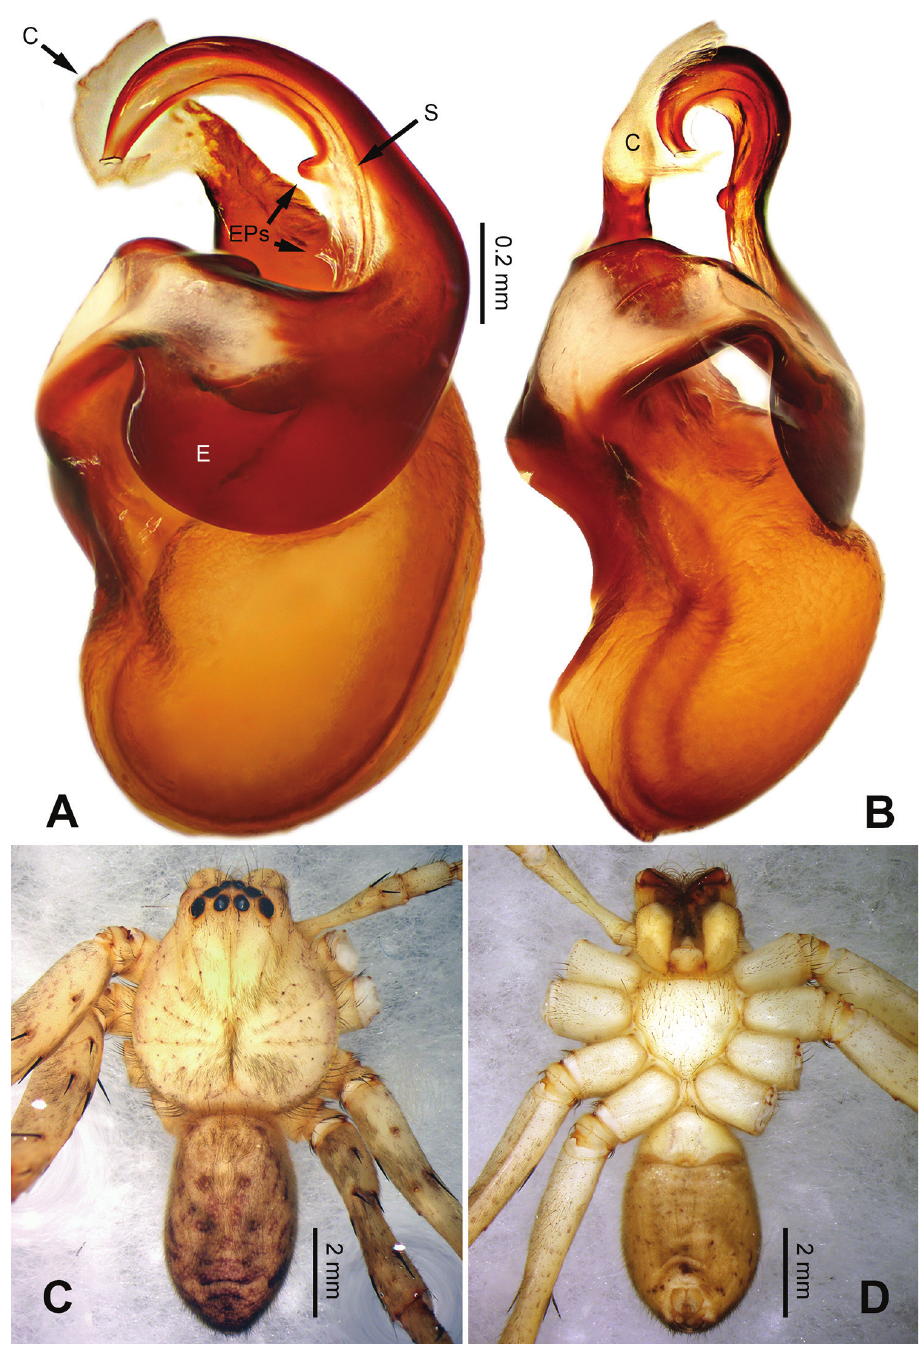
Figure 15. Pseudopoda medogensis Zhao & Li, sp. n., male holotype. A Bulb, ventral view B Bulb, dorsal view C Habitus, dorsal view D Habitus, ventral view. Scale bar equal for A, B